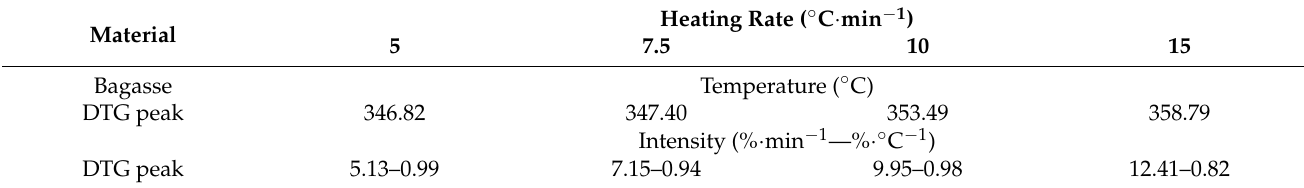
Table 1. Temperature and intensity of DTG peaks at different heating